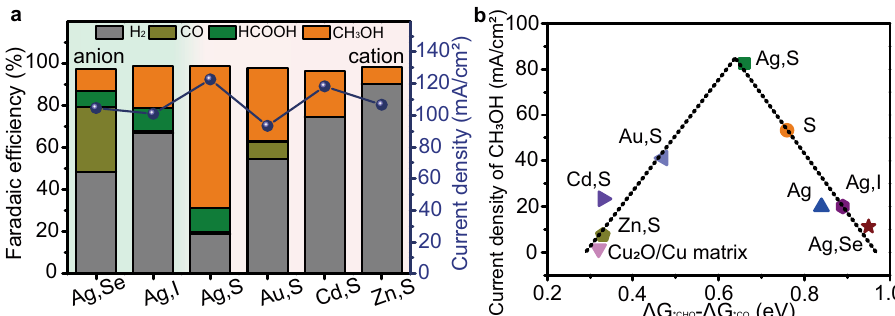
Fig. 3 Anion-cation double doping effect. a The performance of CO 2 RR catalyzed by different dual-doping catalysts at the potential of − 1.18 V vs. RHE. b Plot of the experimentally measured partial current density of methanol versus the theoretically calculated Gibbs free-energy differences of Δ G *CHO and Δ G *CO for different doping